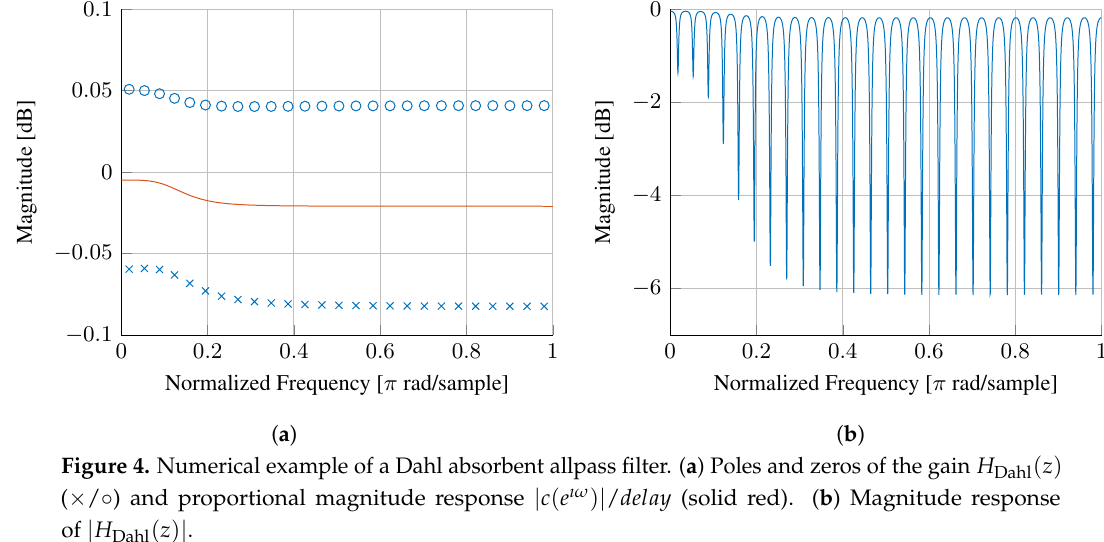
c ( e ı ω ) / delay (solid red). ( b ) Magnitude response | |